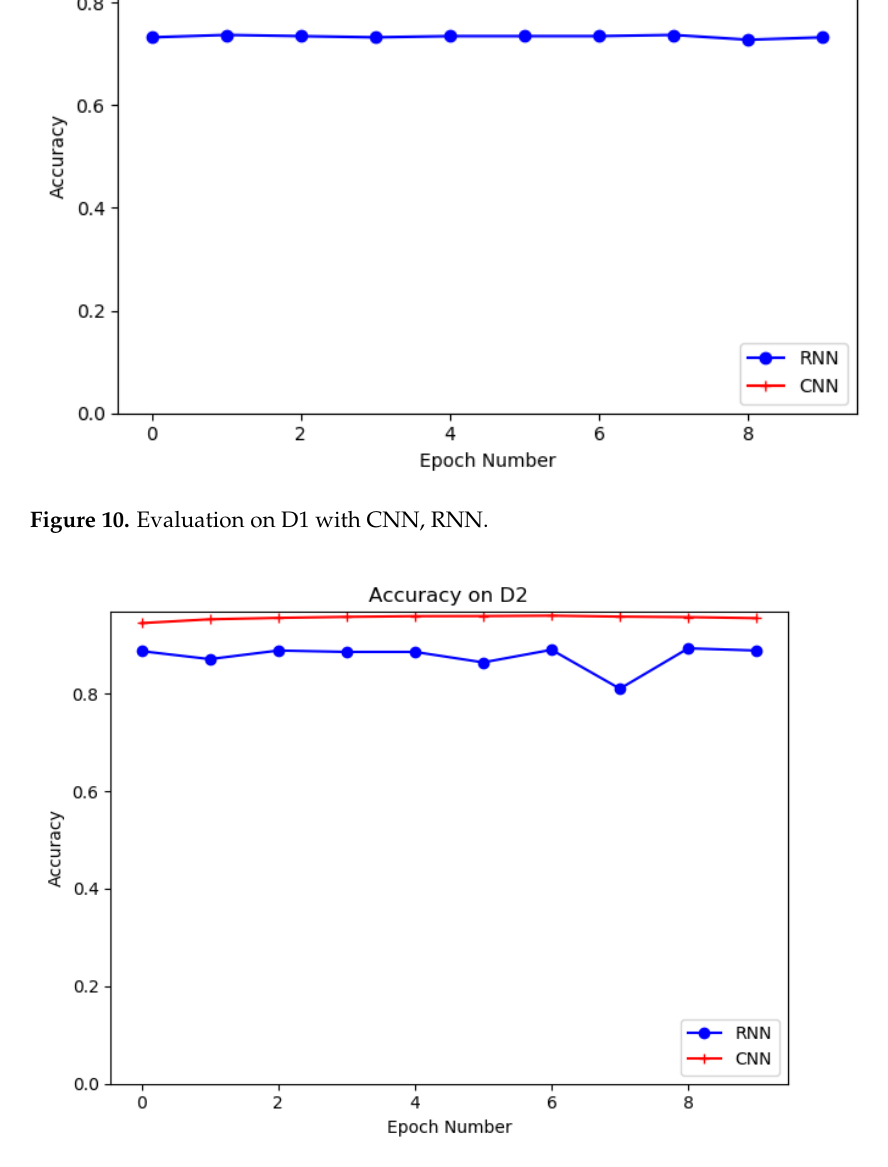
Figure 11. Evaluation on D2 with CNN,